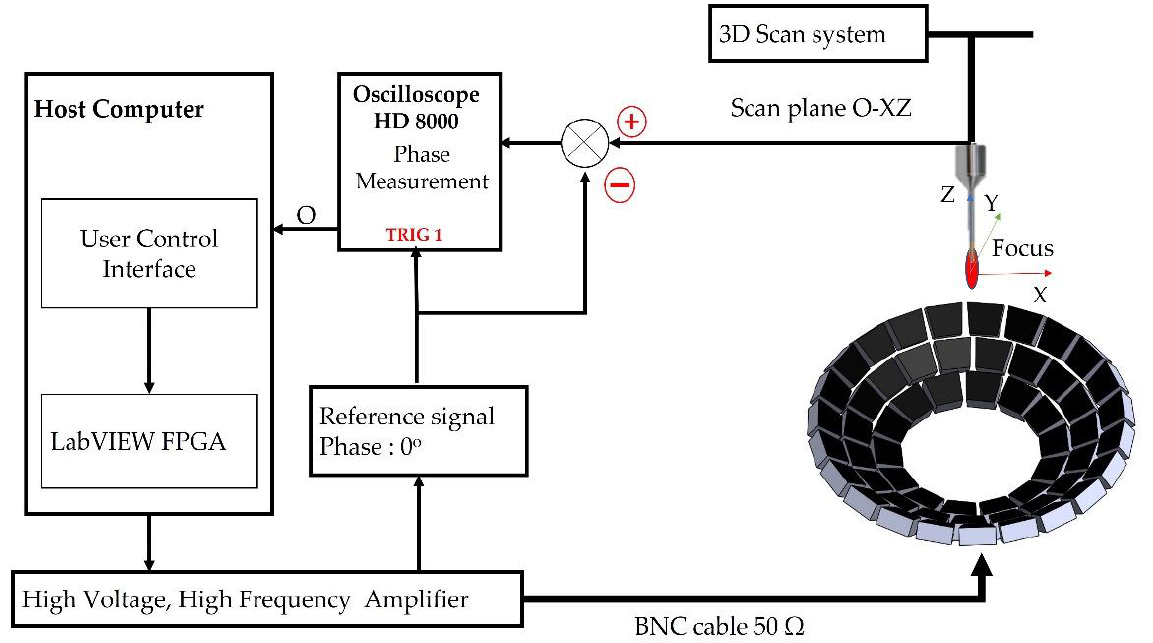
Figure 4. The control diagram to calibrate the UA using PRCM.